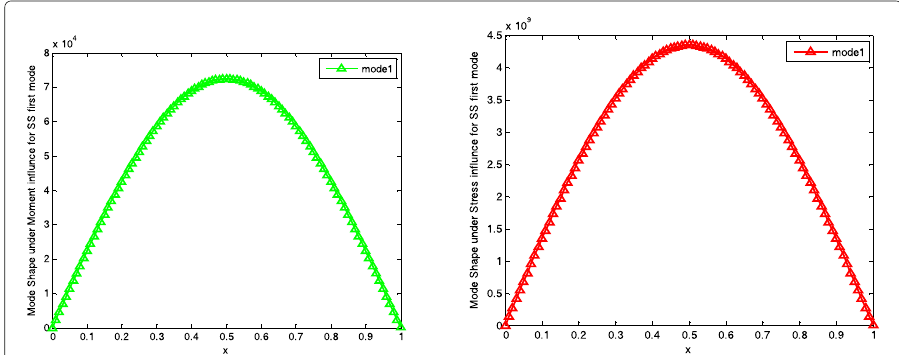
Fig. 5 Fundamental mode shape of SS plate under bending moment and stress respectively